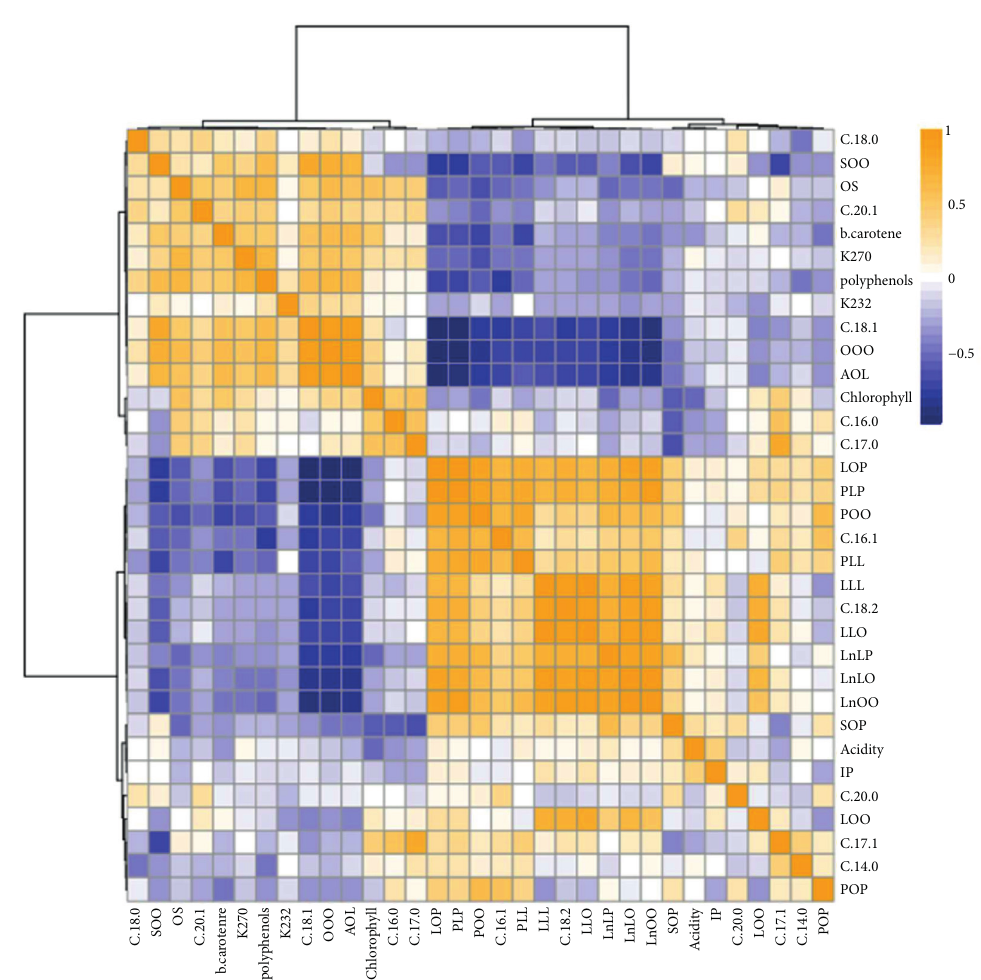
Figure 1: Representation of the correlations between the physicochemical parameters which highly discriminate between cultivars. Table 3: Fatty acid composition of the seven